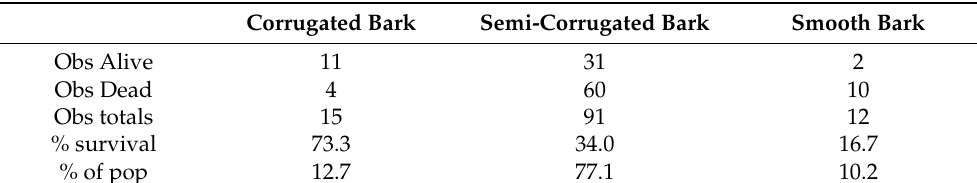
Table 2. Survivorship of Campylocentrum pachyrrhizum on each substrate texture. Bark texture was recorded at each individual on the host trees. Ribbon orchids that grew on corrugated bark had the highest survivorship, but the majority of the orchids were rooted on smooth/semi-corrugated bark. Corrugated Bark